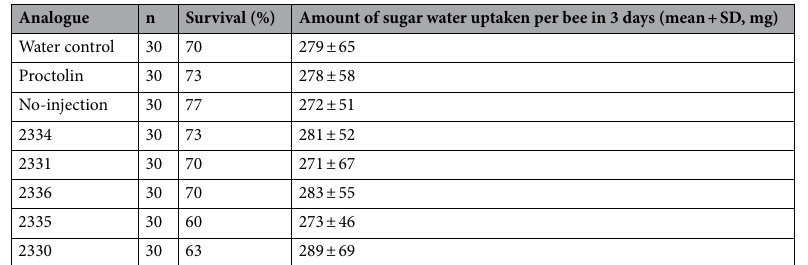
Analogue n Survival (%) Amount of sugar water uptaken per bee in 3 days (mean + SD,